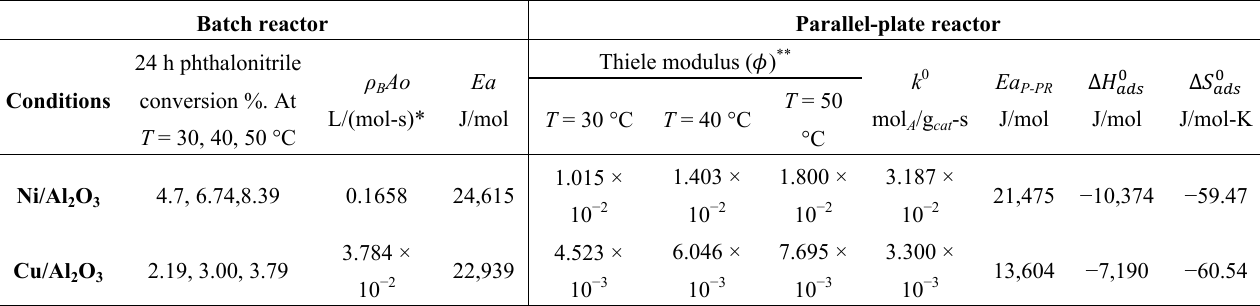
Table 2. Kinetics and mass transfer parameters.